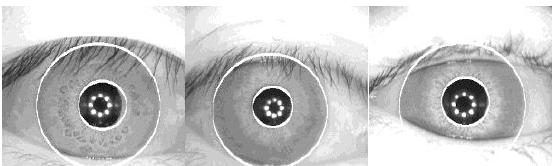
Figure 5. Iris inner and outer boundaries localized for three eye images.